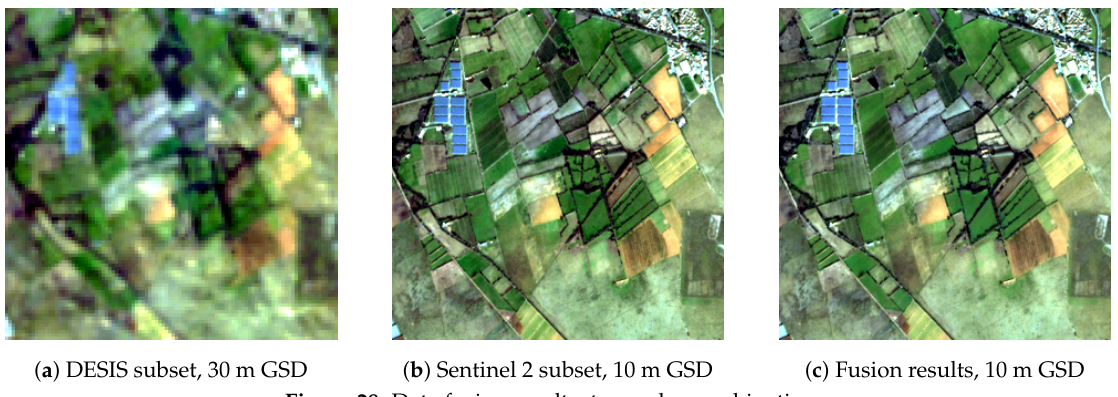
Figure 28. Data fusion results: true color